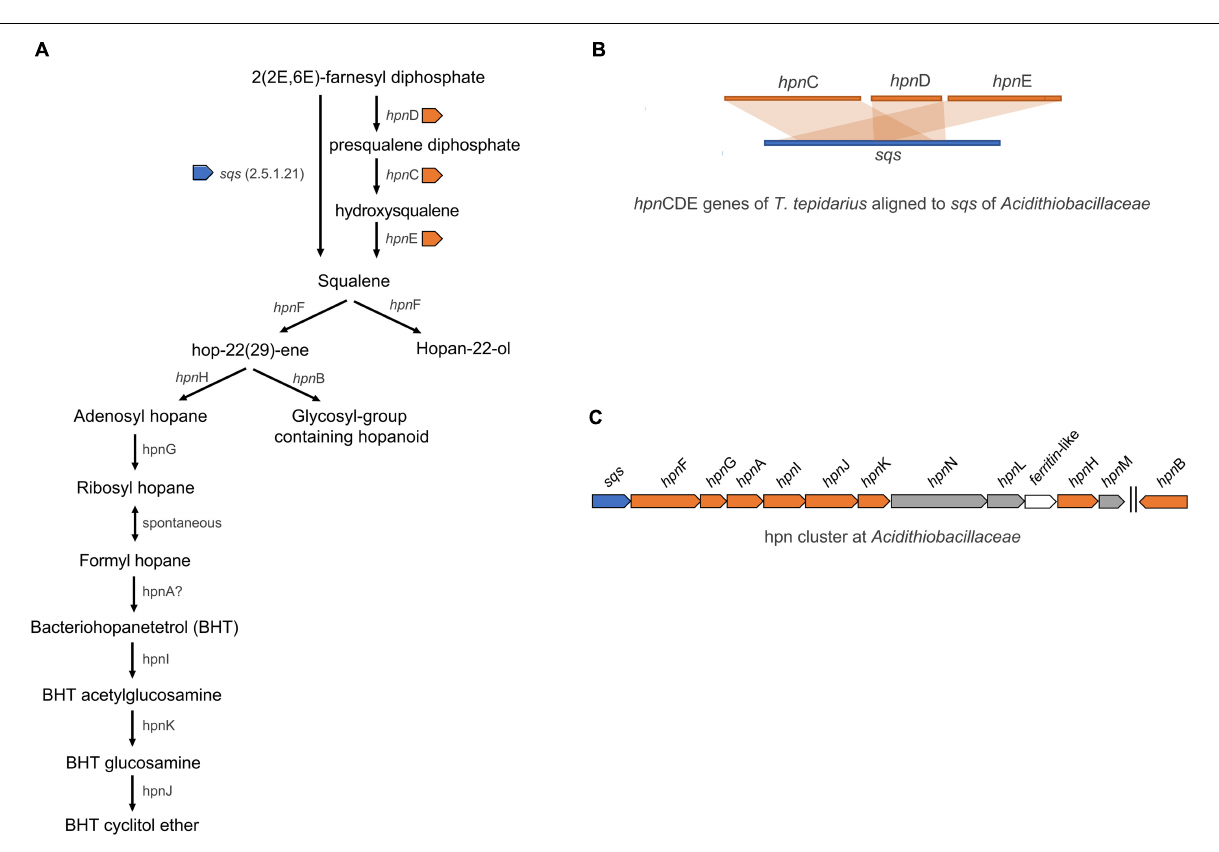
2015). The phosphate transport system genes pst SCAB